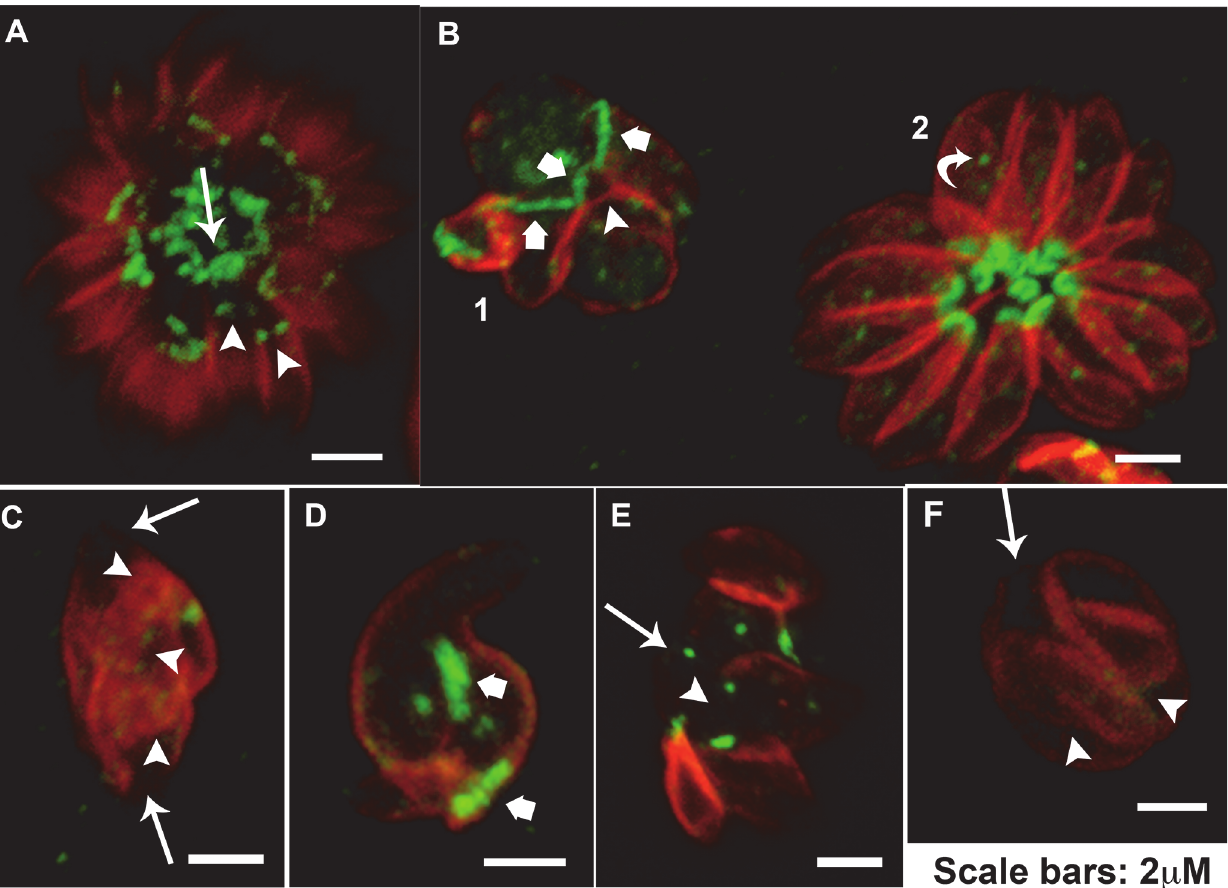
Fig 7. Cipro derivatives and Cipro affect MORN1 localization during parasite division. In parasites presenting normal division process MORN1 localizes at the basal complex of the mother cell (arrow) and also caps the final end of the IMC in budding daughter cells (arrowheads) (A), a single strong point in the middle of the cell was also observed in normal non-dividing parasites (B rosette 2 curved arrow). Tethered daughter cells resulting from the treatment with 5 μ M Et-Cipro (B-C) and Adam-Cipro (D-E) for 24h, and 20 μ M Cipro for 72h (F) showed wide MORN1 basal caps (B and D large arrows) and lack or a weak deposition of MORN1, at the basal end of mother (arrow) and budding daughter cells (arrowheads) (B-F)